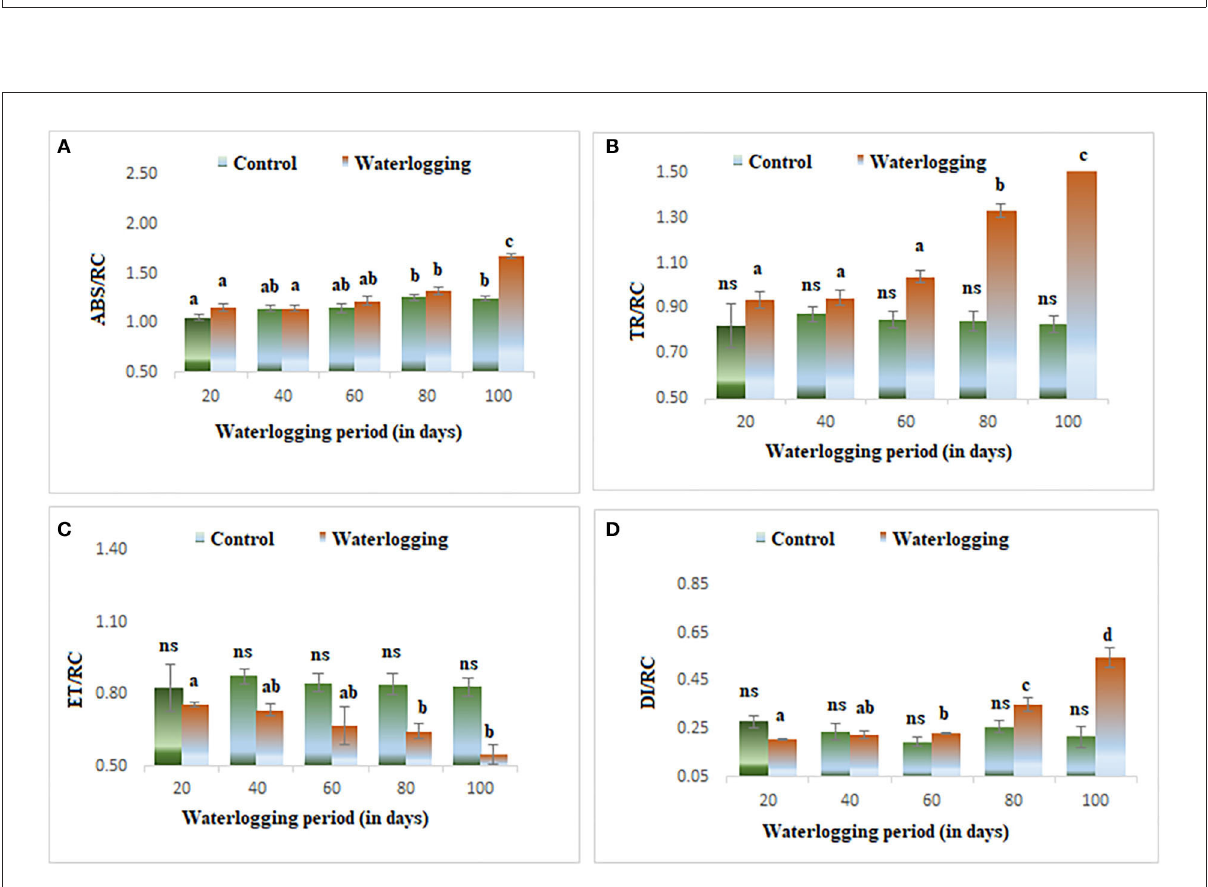
FIGURE7 Waterlogging-induced changes in specific energy fluxes (A) ABS/RC (B) TR/RC (C) ET/RC (D) DI/RC. The letters are the result of post hoc